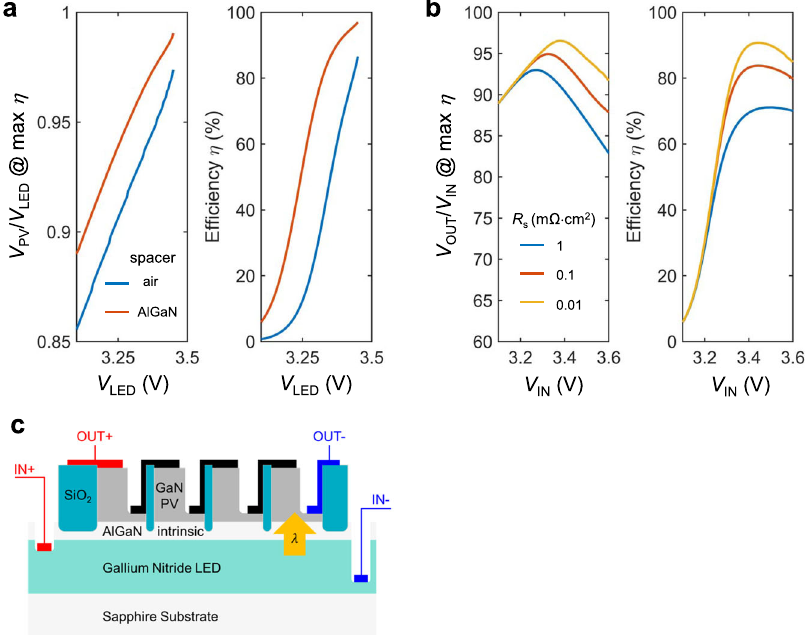
Fig. 2 Theoretical performance of the proposed DC photonic transformer. a Theoretical performance of the proposed GaN photonic transformer with the nonradiative recombination included ( “ Methods ” ). The light blue lines correspond to the case of a 1- μ m thick air spacer layer between the LED and the PV cell, whereas the orange lines are for the case of an Al .5 Ga .5 N spacer layer with a thickness of 1 μ m. Shown in the ef fi ciency plot is the maximum possible ef fi ciency by adjusting the load. b The performance of GaN photonic transformer with the Al .5 Ga .5 N spacer layer with different series resistance R s = R s,PV = R s,LED . We assume the number of PV cells N = 100. c A conceptual monolithic device design of the proposed GaN photonic transformer with an intrinsic AlGaN spacer layer that provides electrical isolation and enhanced optical